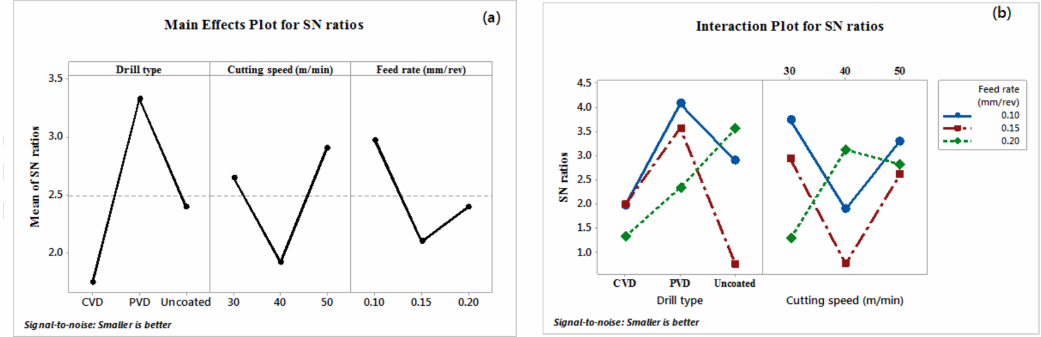
Figure 12. ( a ) Plot of the main effects for the S/N ratio; and ( b ) interaction plot for S/N ratios of surface roughness for (Mg/10 wt %SiC/0.25 wt %GNPs) MMC.